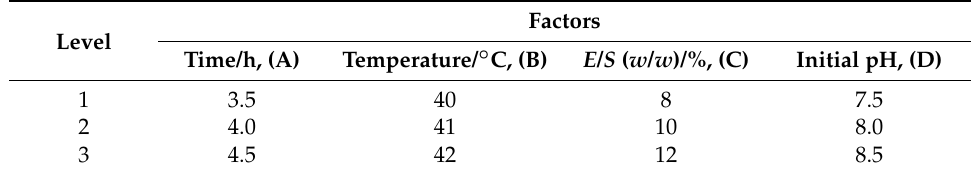
Table 3. The factor and levels of orthogonal experiment for proteolytic conditions of goat milk catalyzed by CEP of L. plantarum